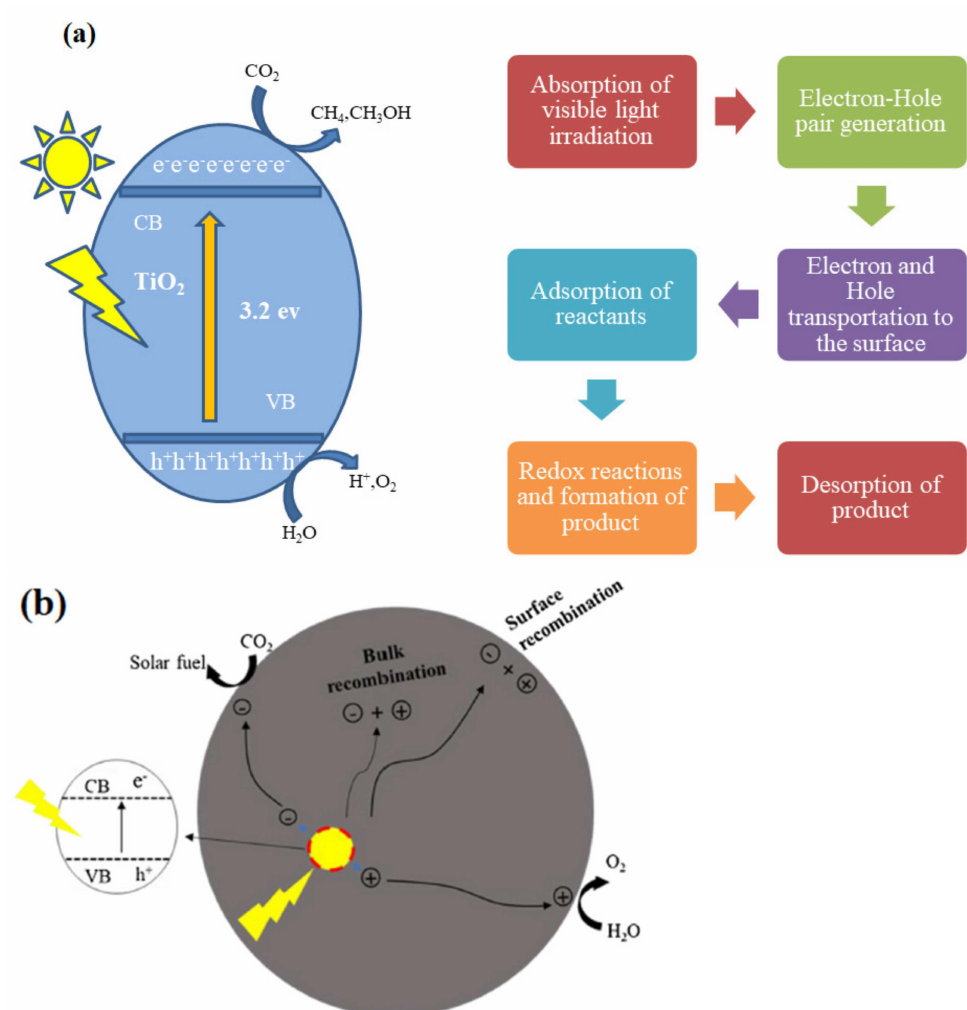
Figure 4. ( a ) Schematic diagram of charge recombination across photocatalyst. ( b ) Illustration of the procedure of photocatalytic CO 2 reduction. Reprinted with permission from Elsevier, 18 December 2021 Ref.